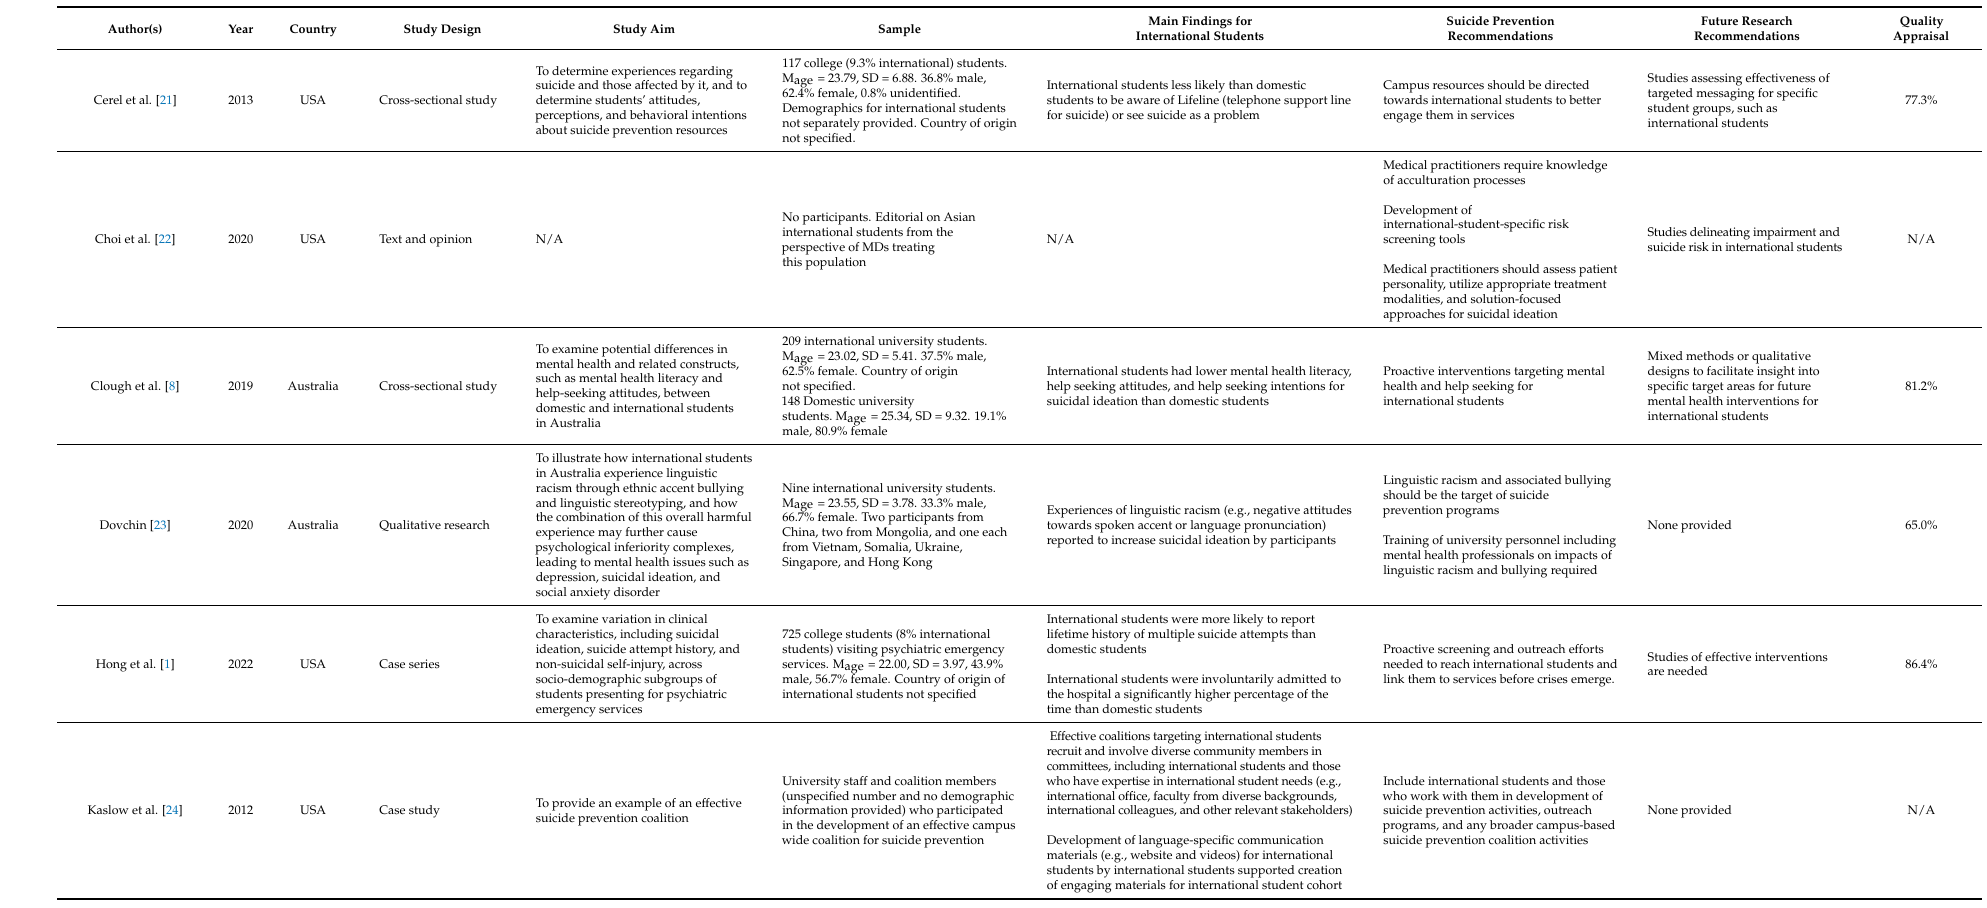
Table 1. Peer-Reviewed Studies on Suicide Prevention among International